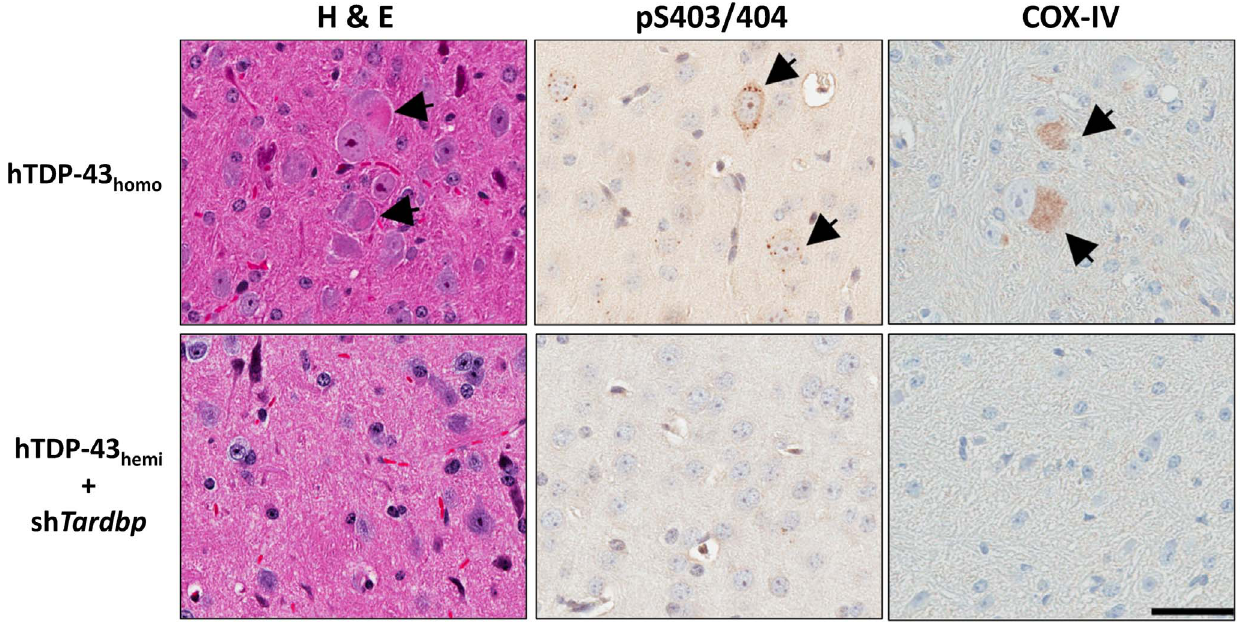
Figure 4. Further downregulation of mTdp-43 in the brain of hTDP-43 hemizygous mice do not induce pathologies observed in hTDP-43 homozygous mice. ( A–B ) Hematoxylin and eosin staining (H&E) shows that eosinophilic aggregates in neurons from the brain sections of 1 month old hTDP-43 homozygous mice ( A ) are not observed in AAV1-sh Tardbp injected hTDP-43 hemizygous mice ( B ). ( C–D ) Phosphorylated TDP-43 aggregates are only observed in the neurons of the brain sections of 1 month old hTDP-43 homozygous mice ( C ), but not in AAV1-sh Tardbp injected hTDP-43 hemizygous mice ( D ). ( E–F ) COX-IV immunoreactivity illustrates densely stained mitochondria aggregates in neurons from the brain sections of 1 month old hTDP-43 homozygous mice ( E ), but not in AAV1-sh Tardbp injected hTDP-43 hemizygous mice ( F ). Scale bars: 100 m